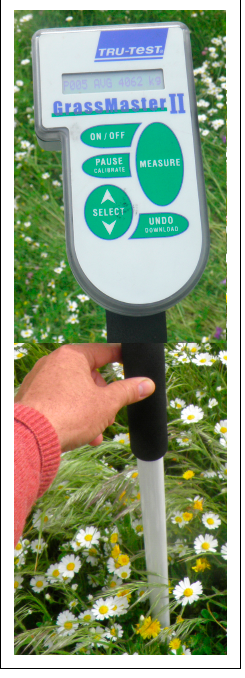
Figure 8. Grassmaster II electronic capacitance probe used to estimate pasture biomass.